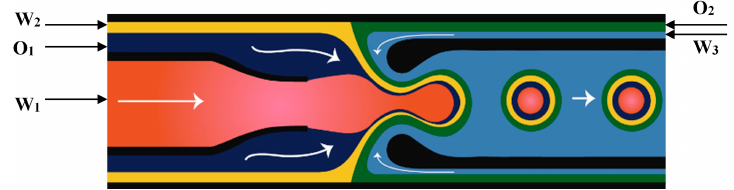
Figure 26. Glass capillary device for the preparation of W 1 /O 1 /W 2 /O 2 /W 3 quadruple emulsion. One additional small capillary (not shown here) is placed between the injection and outer capillary [151].